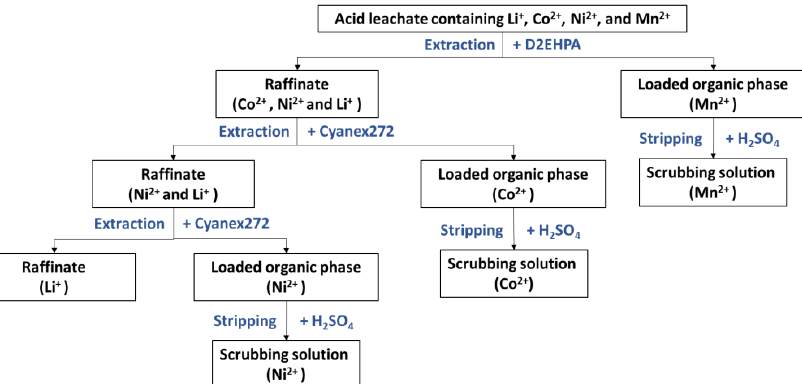
Figure 1. Proposed flowchart for recovering Li, Co, Ni, and Mn from the leachate via solvent extrac- tion.